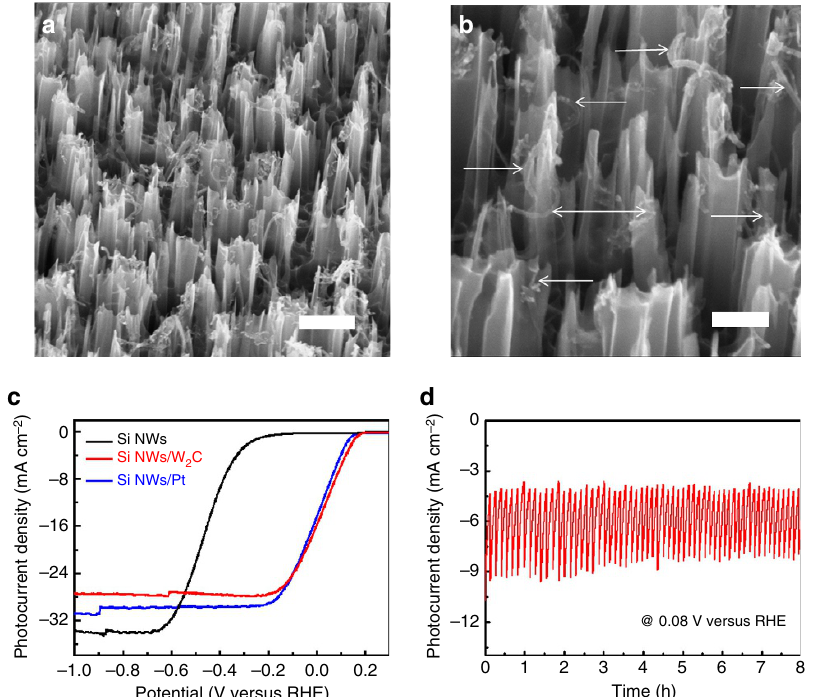
Figure 5 | Integration of W 2 C/MWNT with p-type Si nanowires for PEC hydrogen generation in 0.5M H 2 SO 4 . ( a , b ) SEM images of the photocathode loaded with W 2 C/MWNT catalyst as marked by arrows. Scale bar, 400nm ( a ) and 200nm ( b ). ( c ) Polarization curve of Si nanowire photocathode loaded with W 2 C/MWNTunder one sun illumination in comparison with the same photocathode loaded with 20wt% Pt/C or Si nanowire photocathode alone. ( d ) Amperometric i (cid:2) t curve at a constant potential of 0.08V versus RHE under one sun